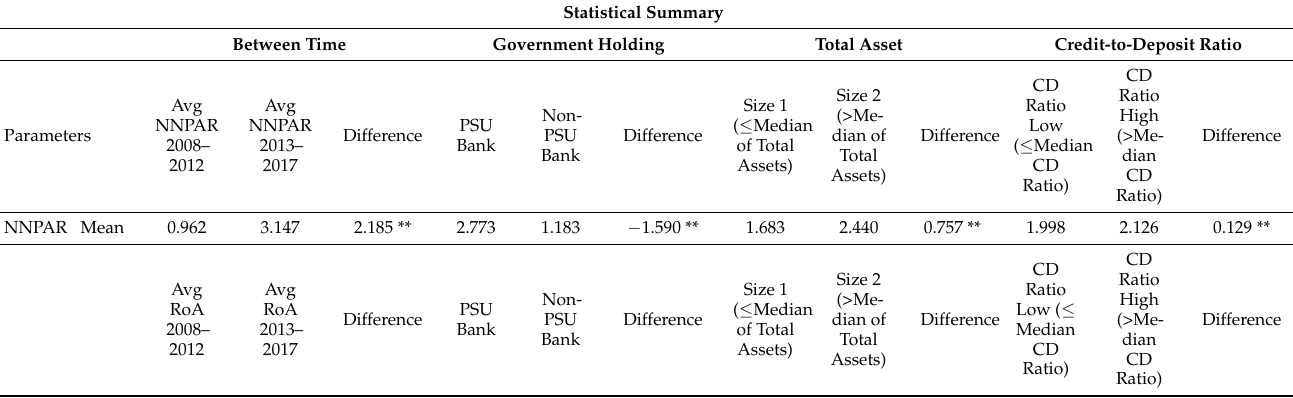
Table A5. Shows the differences in mean for different financial parameters for 380 bank years over 2008–2017. The financial parameters used here are defined after the statistical